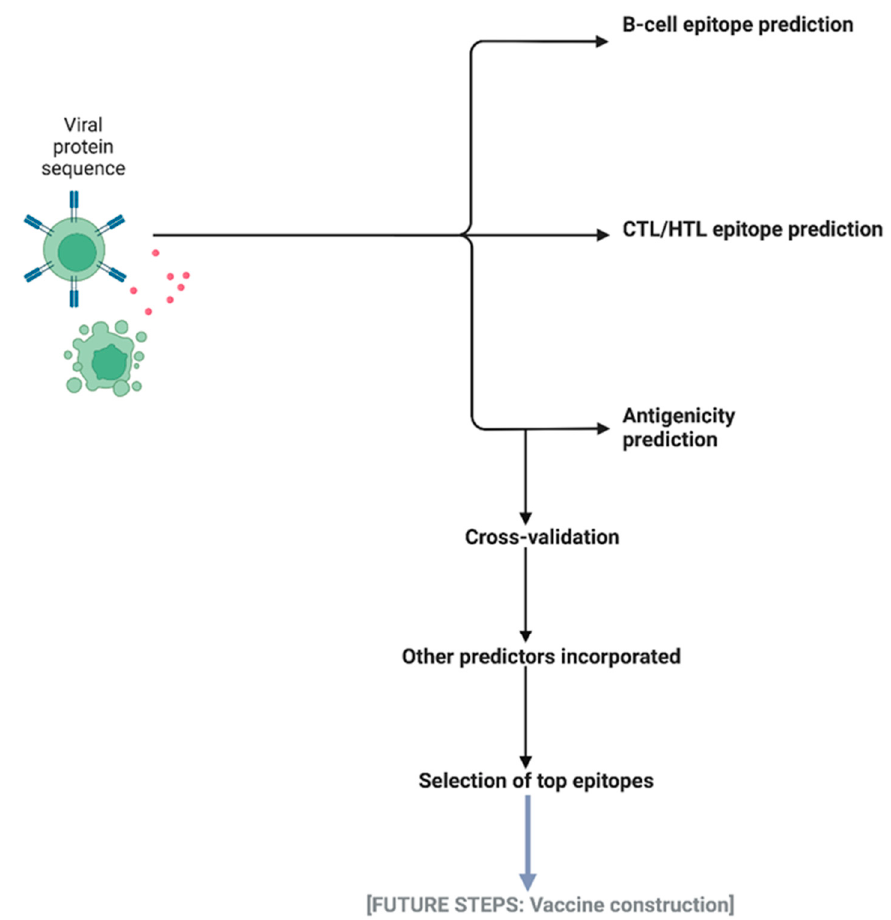
Figure 8. In using IntegralVac for eventual vaccine construction, we follow the same steps as our referenced models for the evaluation and selection of highly immunogenic peptides. This number should be greatly decreased (i.e., <30) from the dataset that the epitopes were selected from, as only the most highly antigenic and least allergenic epitopes would be utilized in a vaccine. Although our study investigated primarily T-cell epitopes, a fully comprehensive vaccine would select B-cell epitopes, as well, for maximal coverage.